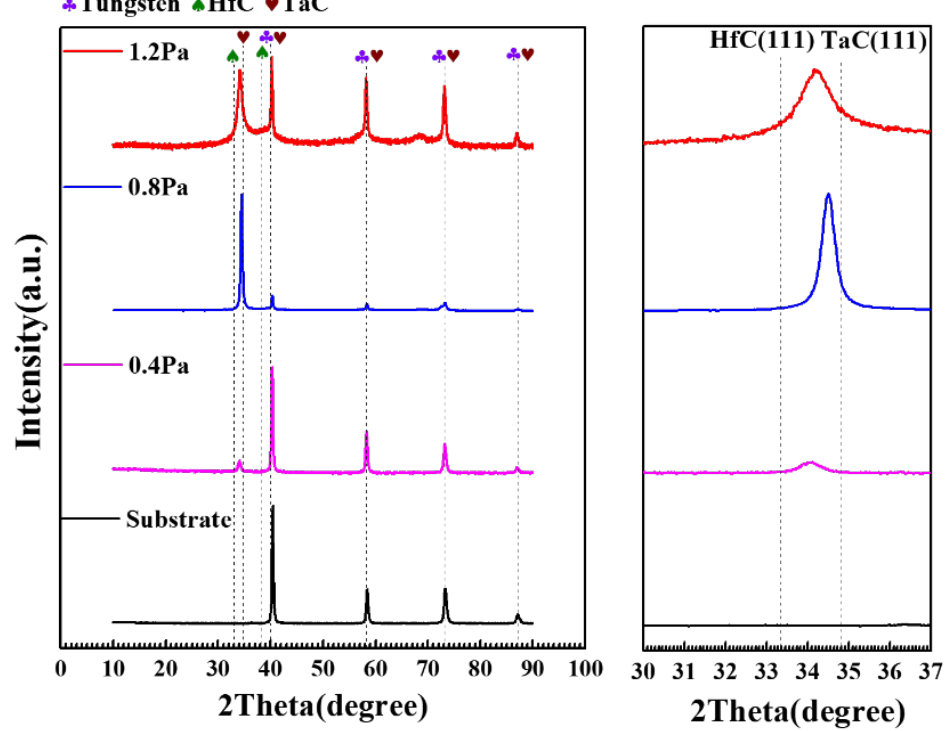
Figure 3. XRD patterns of Ta-Hf-C coatings under different working pressures.